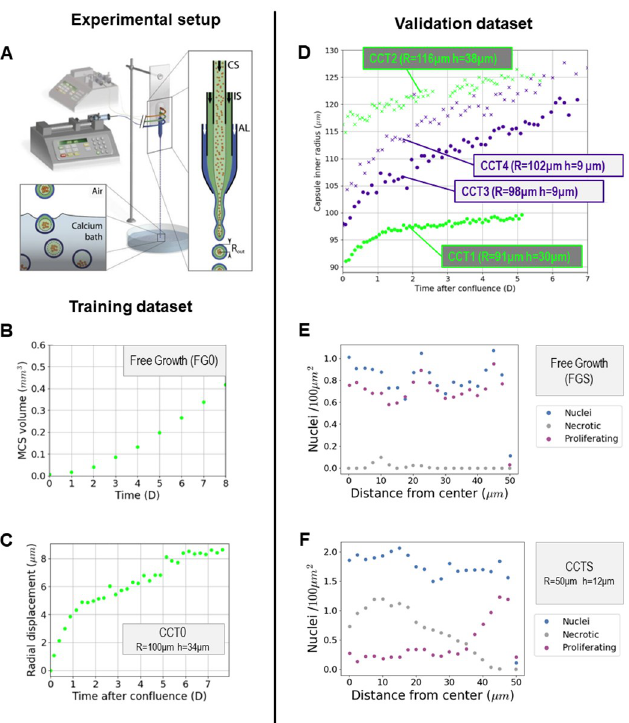
Fig 1. CCT experimental setup and data. A CCT microfluidic co-extrusion device; the enlarged view of the chip shows the three-way configuration, with cell suspension (CS), intermediate solution (IS), and alginate solution (AL), respectively, flowing into the coaligned capillaries. B , C Experimental training data: B free growth MCTS control group (FG0), the volume is monitored over a time span of 8 days; C encapsulated MCTS, the radial displacement of the capsule (CCT0) is monitored over a time span of 8 days. D Validation dataset: two capsules, denoted as thick CCT1 and CCT2; two capsules, denoted as thin CCT3 and CCT4. Their strains are monitored over a time span of 5 to 7 days. E , F Experimental quantification of cell nuclei (blue), proliferating cells (purple), and dead cells (gray) along the radius for small free (FGS), E , and small confined (CCTS), F , spheroids [7].